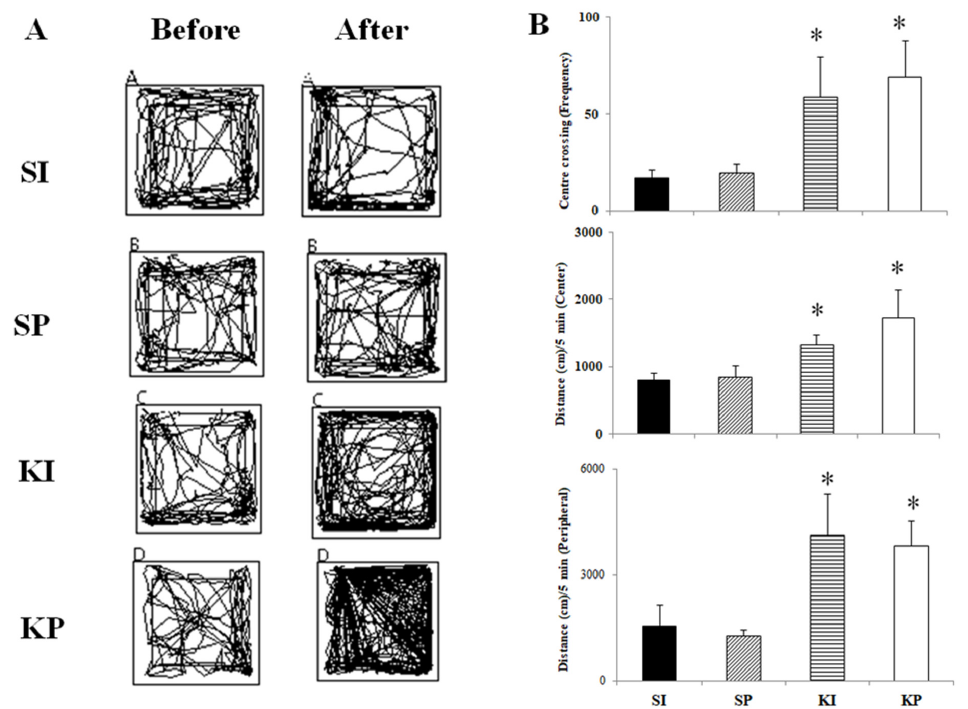
Figure 3. The effect of ketamine inhalation on behavior during the open field test (OFT). KI and KP mice had increased locomotor activity tracks, but SI and SP mice did not ( A ). KI and KP mice had higher center crossing frequency, center travel distance, and peripheral distance when compared to SI and SP mice ( p < 0.05) ( B ). The values are expressed in means ± SD. An asterisk indicates a significant difference in Bonferroni post-tests following one-way ANOVA ( p < 0.05).